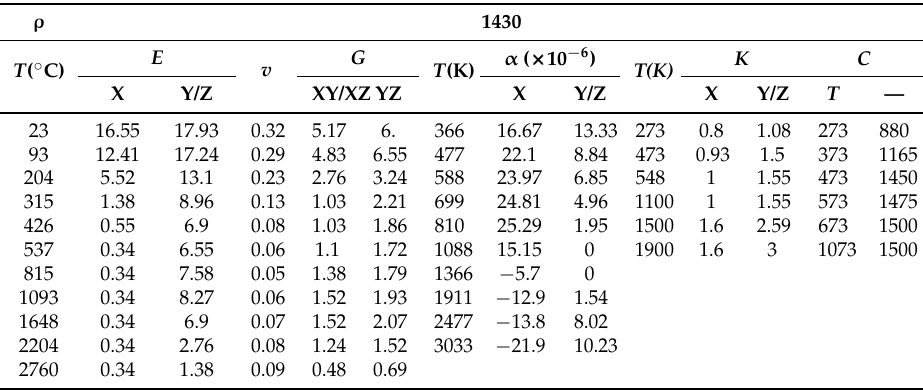
Table 3. Material properties of carbon-phenolic-resin